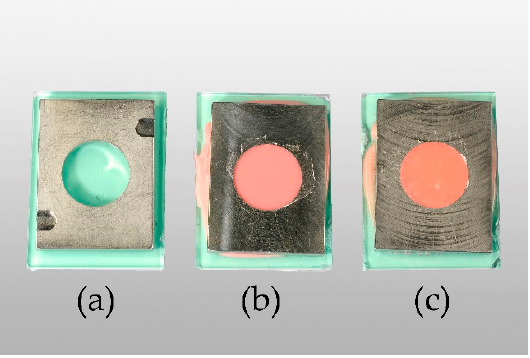
Figure 2. From left to right: empty templet ( a ), Ufi Gel P (UG) specimen in templet after setting ( b ), Coe-Soft (COE) specimen in templet after setting ( c ).